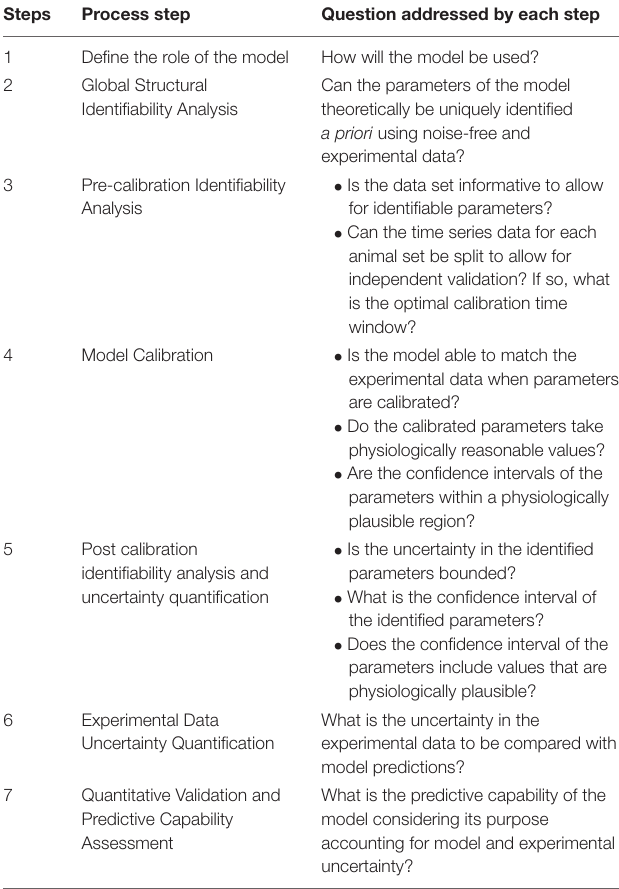
TABLE 1 | Step by step workflow followed for subject specific model reliability